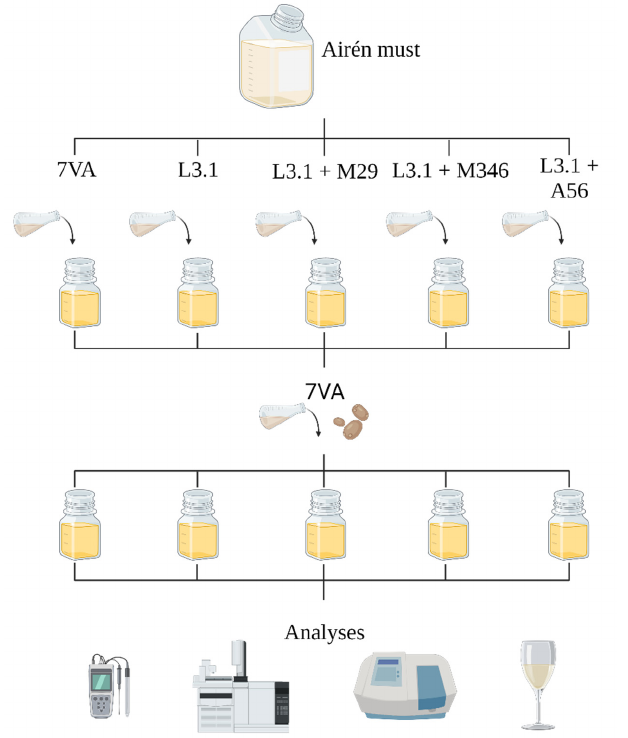
Figure 1. Schematic representation of the experimental set-up for the assessment of the synergetic interaction of Mp strains and L3.1.